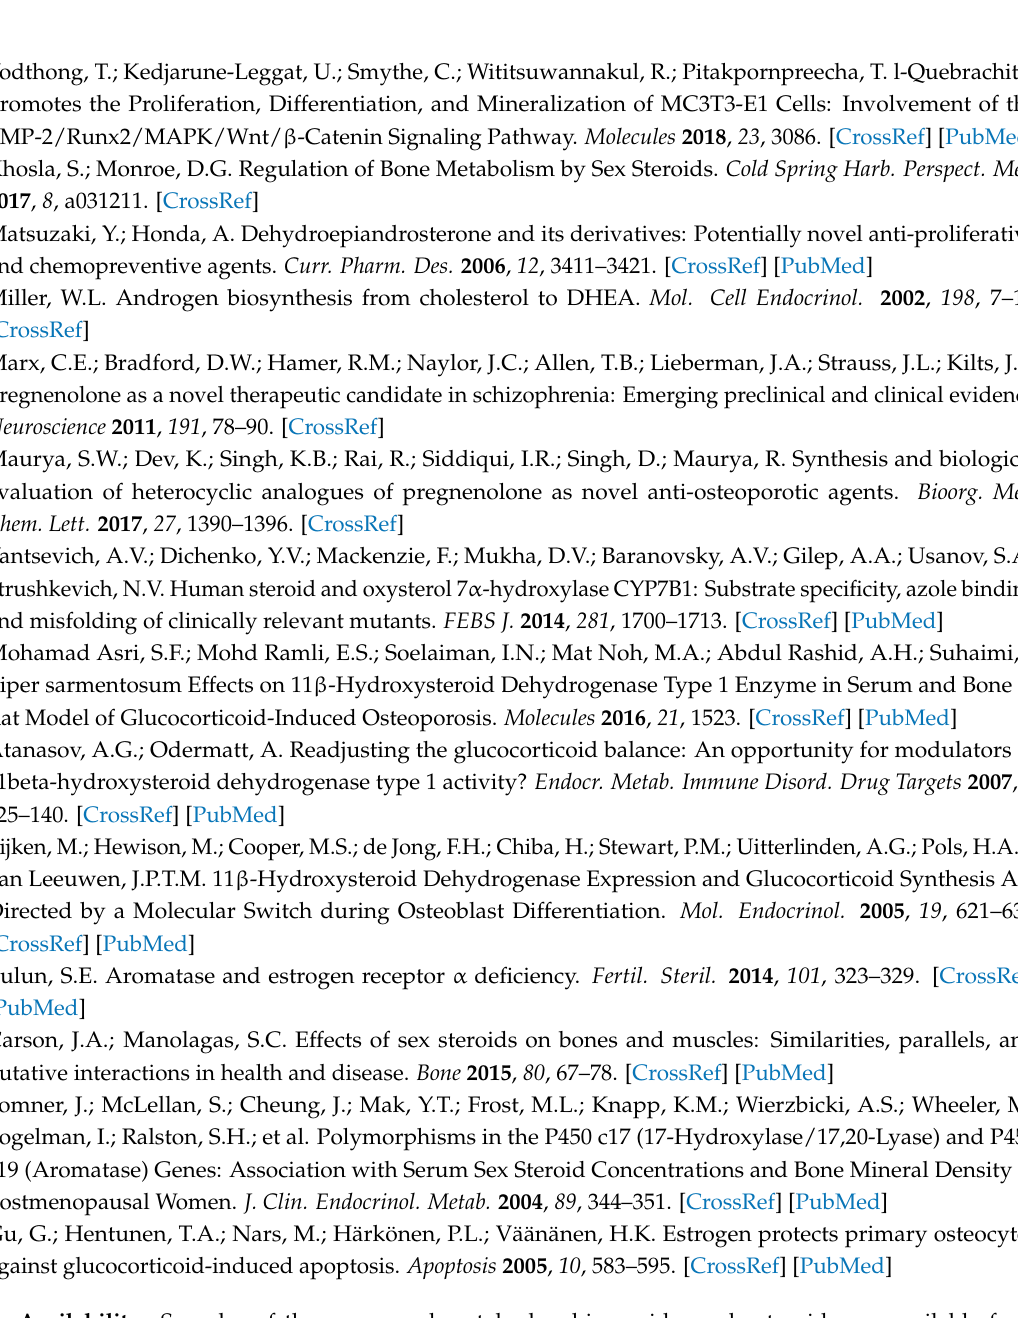
Sample Availability: Samples of the compounds catalpol, echinacoside, and acteoside are available from the